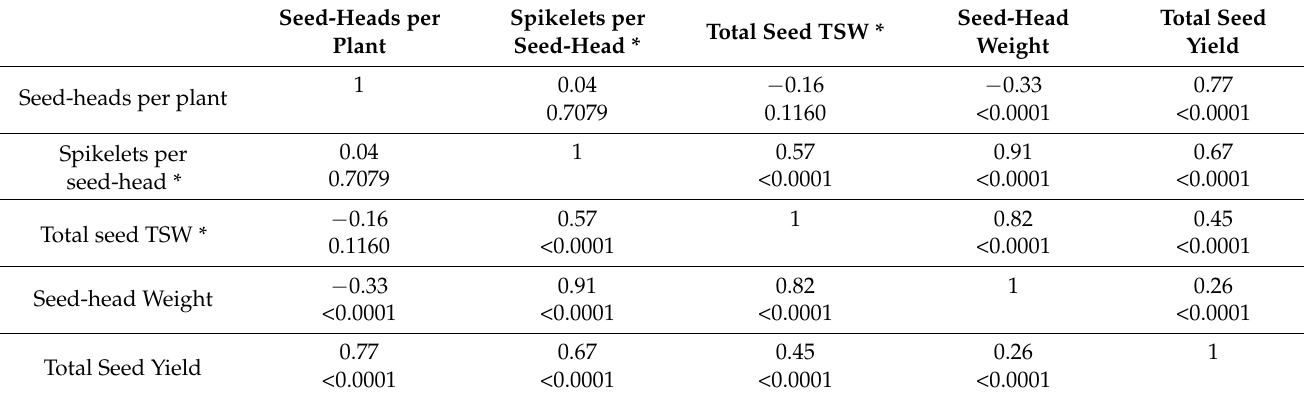
Full seeds and ergot sclerotia fractions had a large and negative correlation (Table 5). Similarly, empty seeds showed a negative correlation with full seeds although at a lower magnitude. The overall correlation between empty seeds and ergot sclerotia was not sig ‐ nificant. Similar trends were observed when the correlations of the different fractions were analyzed on a by ‐ weight basis.